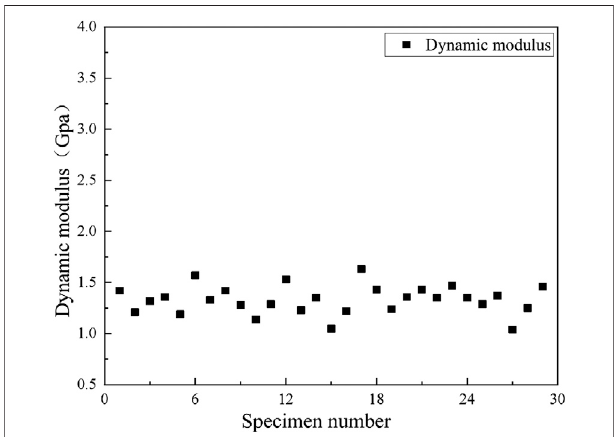
FIGURE 3 | Test results of dynamic modulus of asphalt